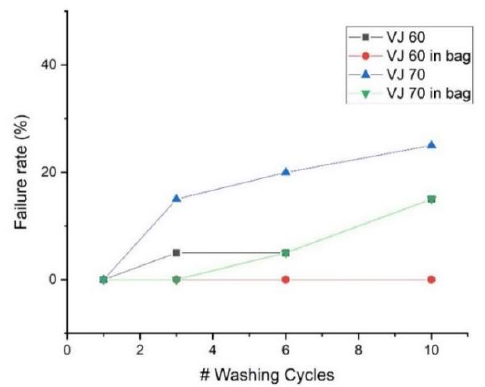
Figure 5. Life of diodes versus number of washing cycles (two types of washing, two pastes).